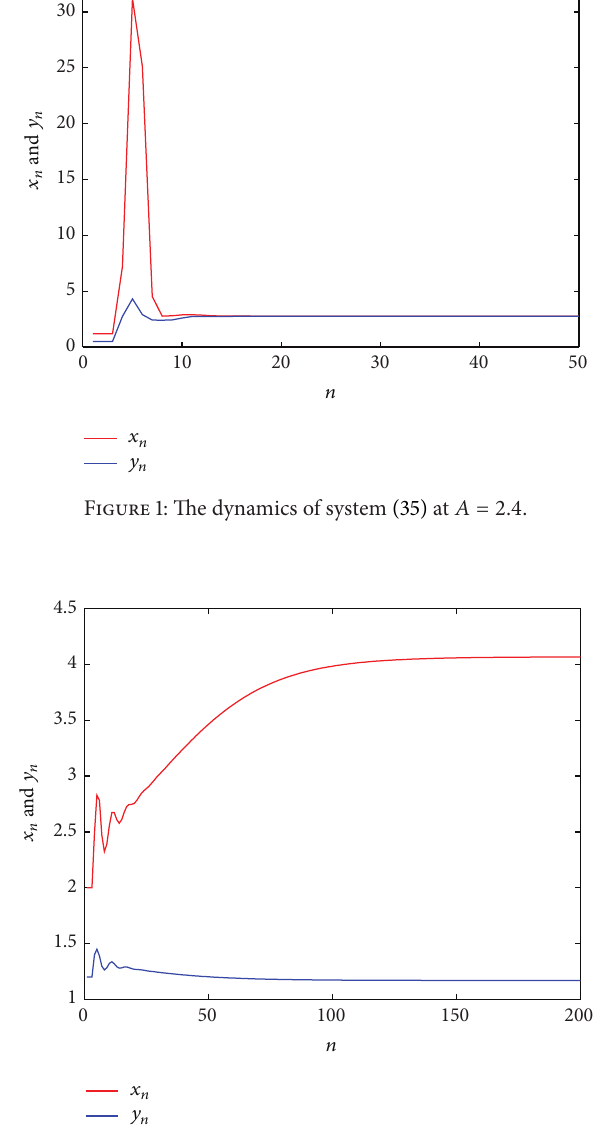
Figure 2: The dynamics of system (35) at 𝐴 = 1.1